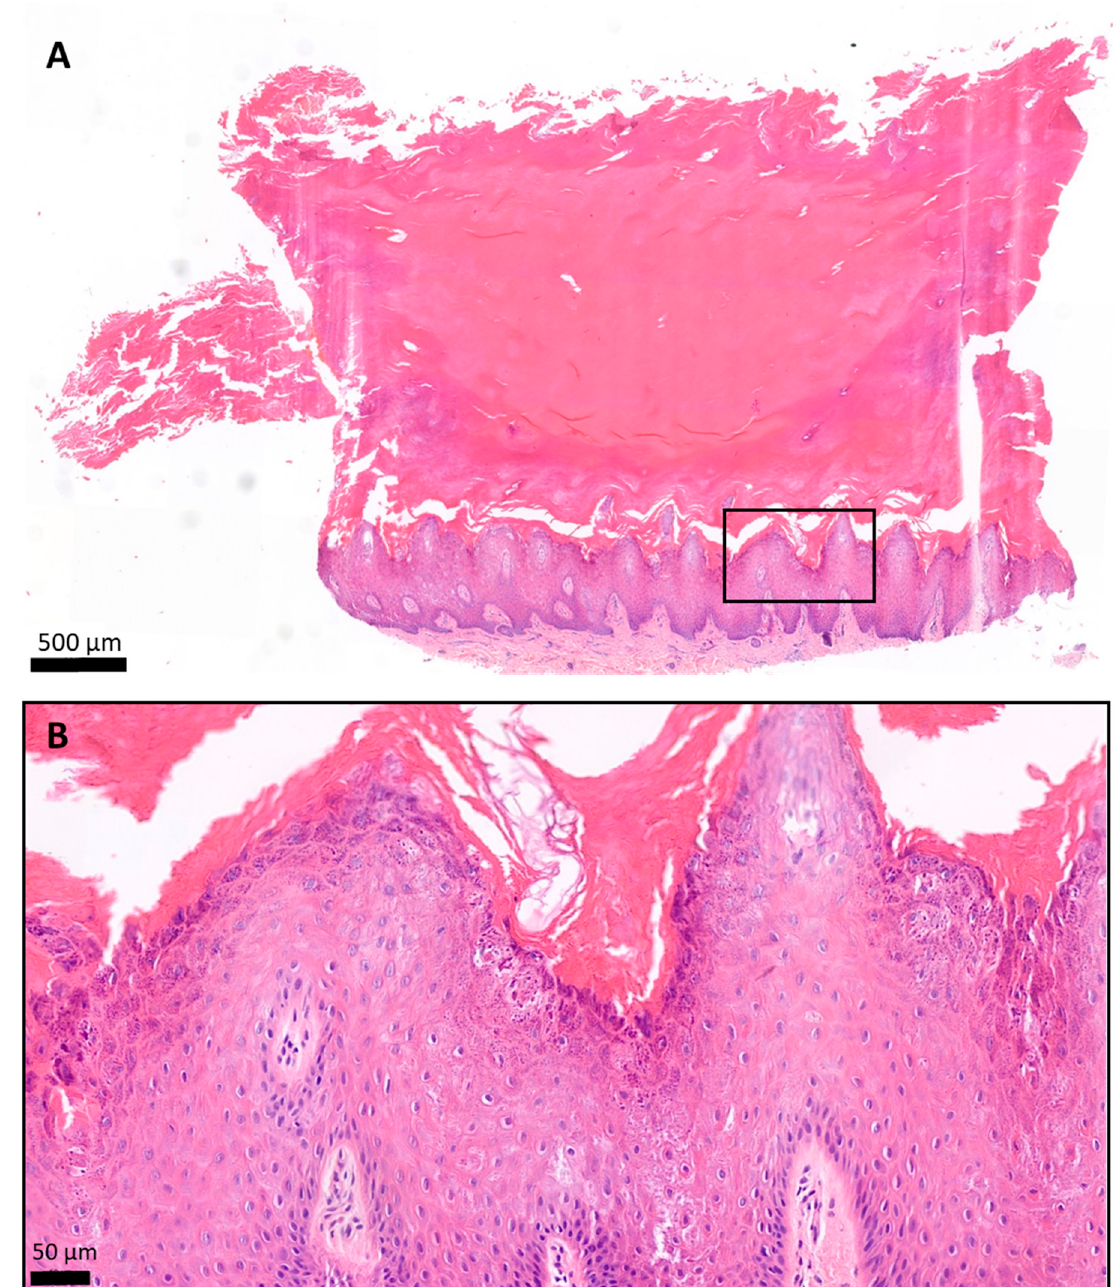
Figure 8. Histology of the plantar keratoderma of the patient, hematoxylin and eosin (H&E) staining. The skin biopsy specimen had a structure typical of acral localization. ( A ) The surface was covered by a very thick hyperkeratotic and orthokeratotic horny layer. ( B ) The epidermis was significantly acanthotic and slightly papillomatous. The stratum granulosum was widened. The keratohyaline granules were differently shaped and sized and showed perinuclear vacuolization of the keratinocytes. The basal membrane was intact. ( A ) 2.8× magnification; scale bar: 500 μ m; pixel size: 0.184 pixels/ μ m. ( B ) 19.9× magnification; scale bar: 50 μ m; pixel size: 1.12 pixels/ μ m.